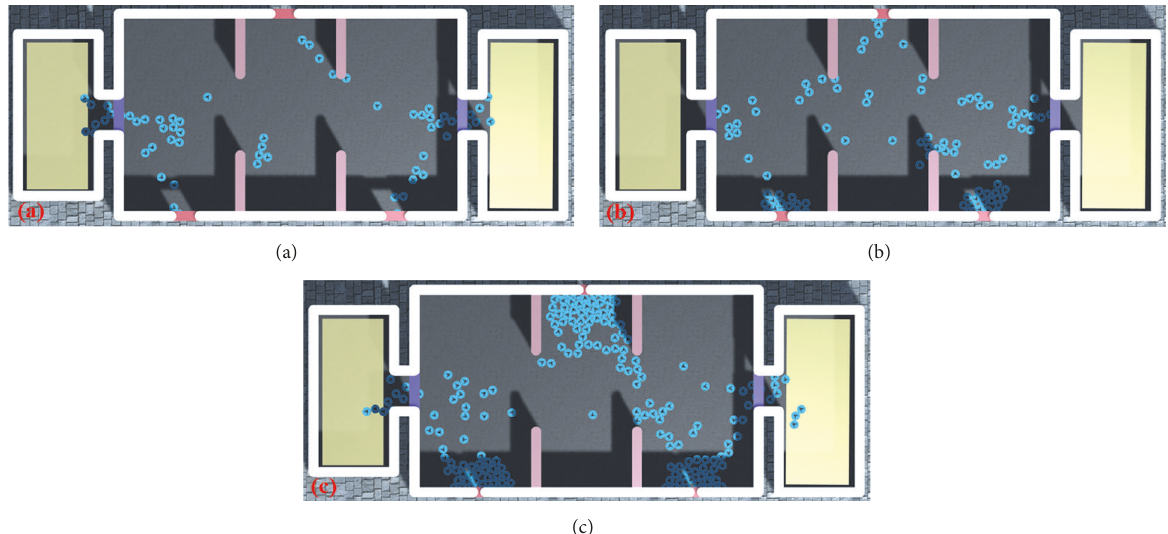
Figure 5: Still images from the simulation setups 4, 5, and 6 (Images (a), (b), and (c), respectively). The three setups share the same type of geometry except for their widths of exits. In setups 1, 2, and 3 exit widths are, respectively, 150cm, 100cm, and 50cm. Therefore, they create evacuation scenarios in the same geometric layout and under three different levels of